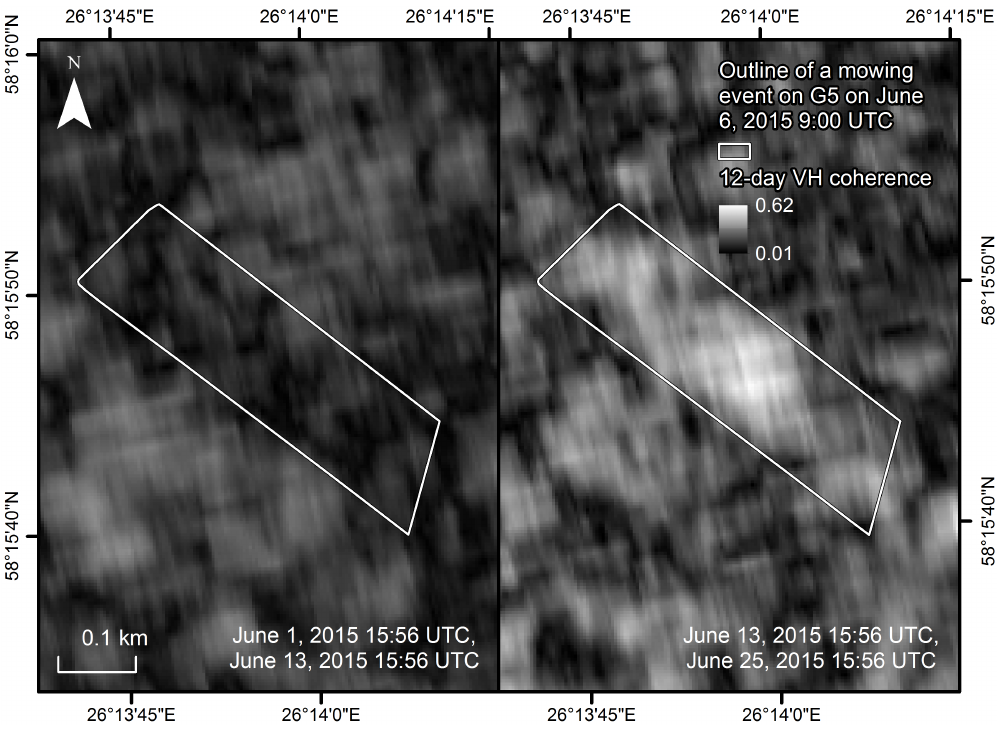
Figure 4. Sentinel 1A 12-day VH coherence before ( left ) and after ( right ) a mowing event on G5 on 6 June